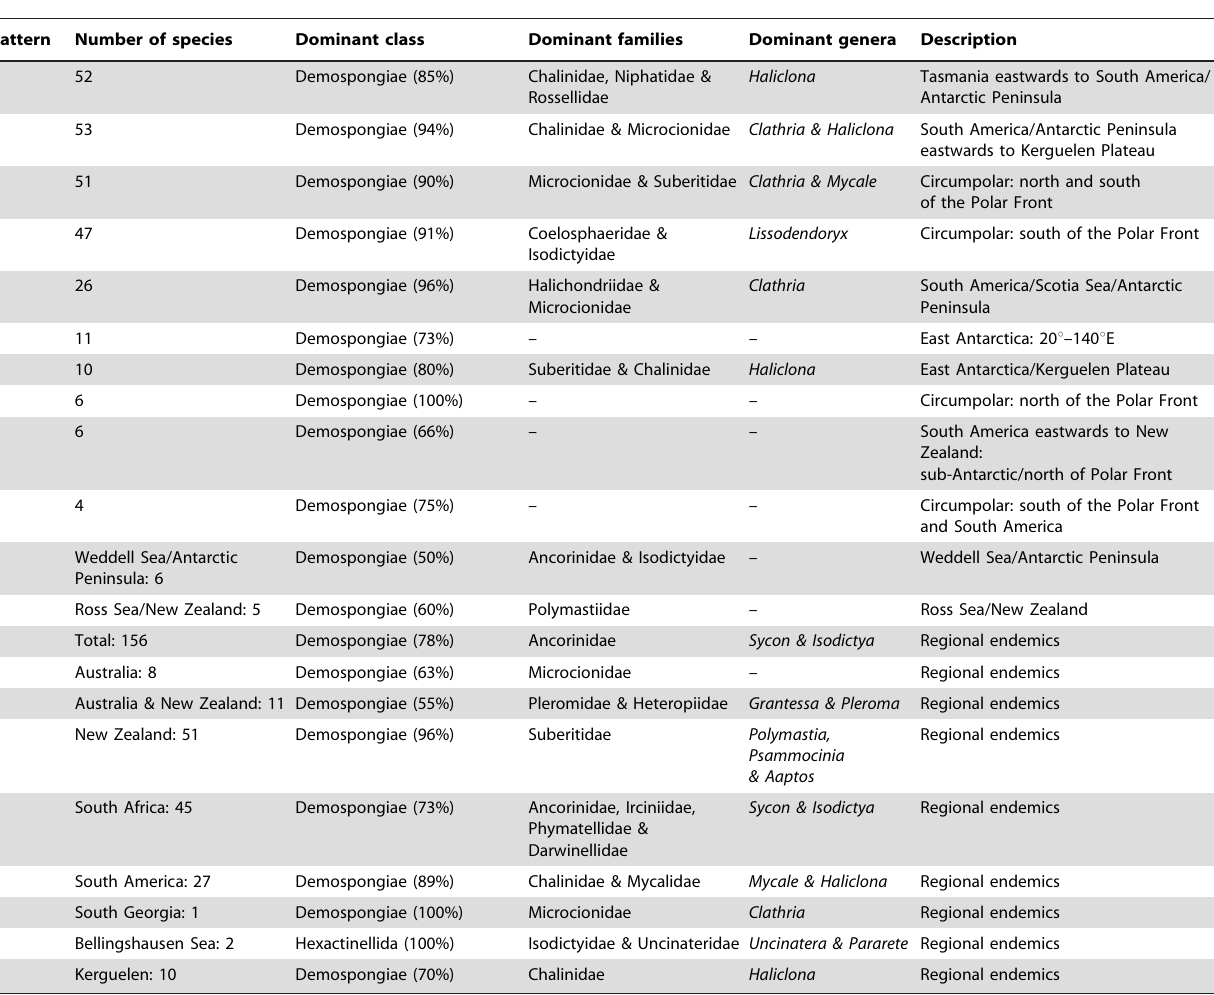
Table 2. Summary of the major distribution patterns of sponge species found at three or more locations within the Southern Ocean and neighbouring regions (also see Fig.